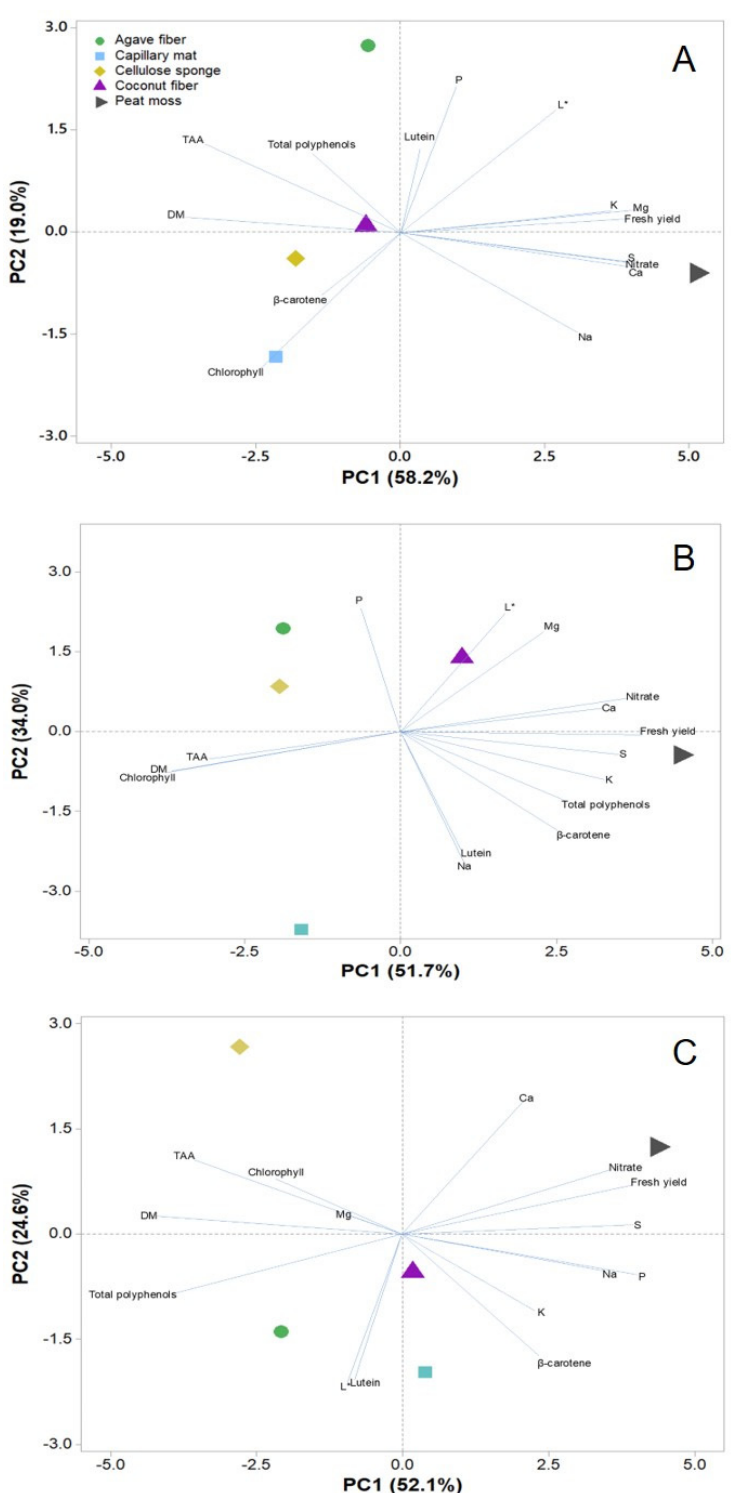
Figure 2. Principal component analysis loading plot of yield, mineral and phytochemical composition traits of coriander ( A ), kohlrabi ( B ) and pak choi ( C ) microgreens cultivated on natural fiber and synthetic substrates in a controlled growth environment.